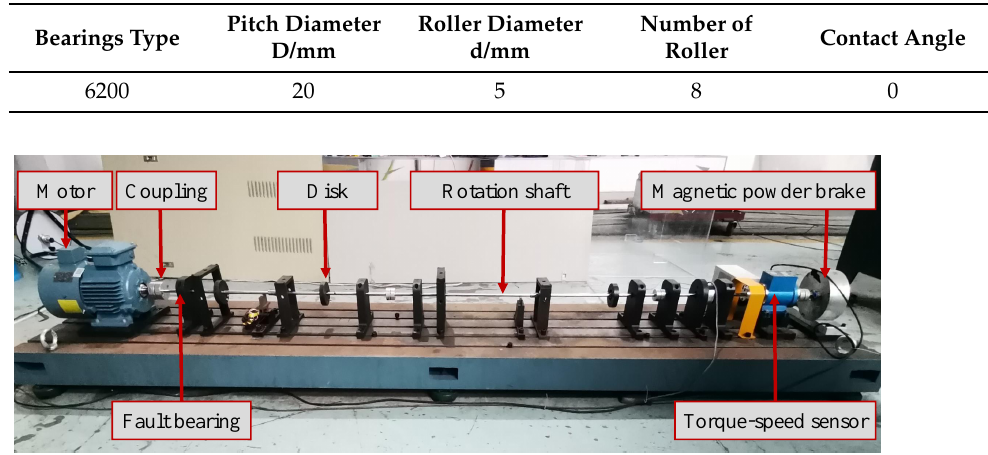
Table 1. Rolling element bearings parameters.